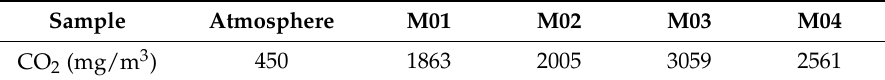
Table 4. The carbon dioxide content.